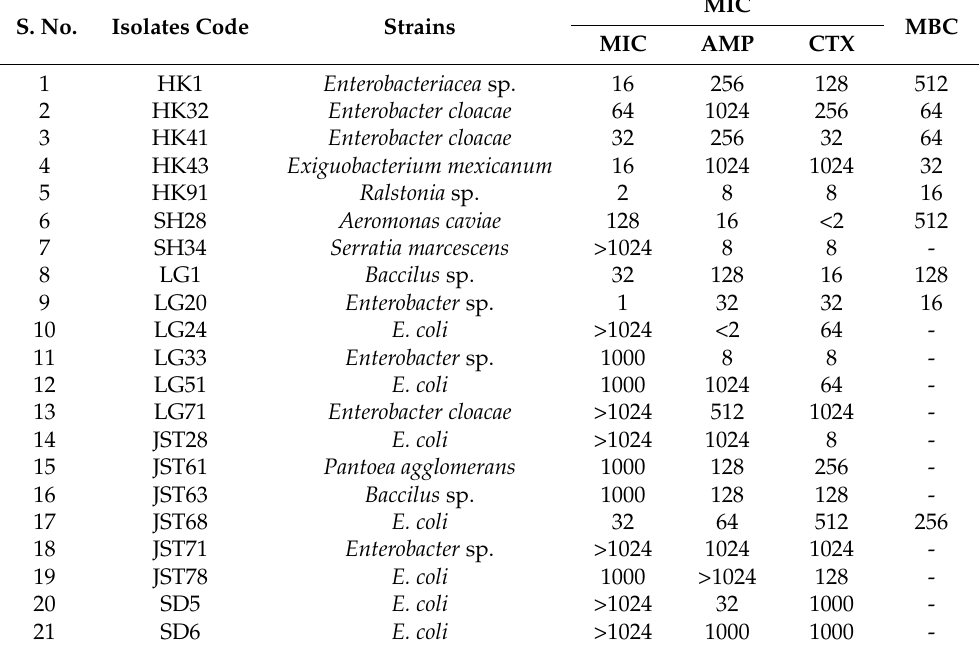
Table 7. MIC and MBC values in µ g/mL.